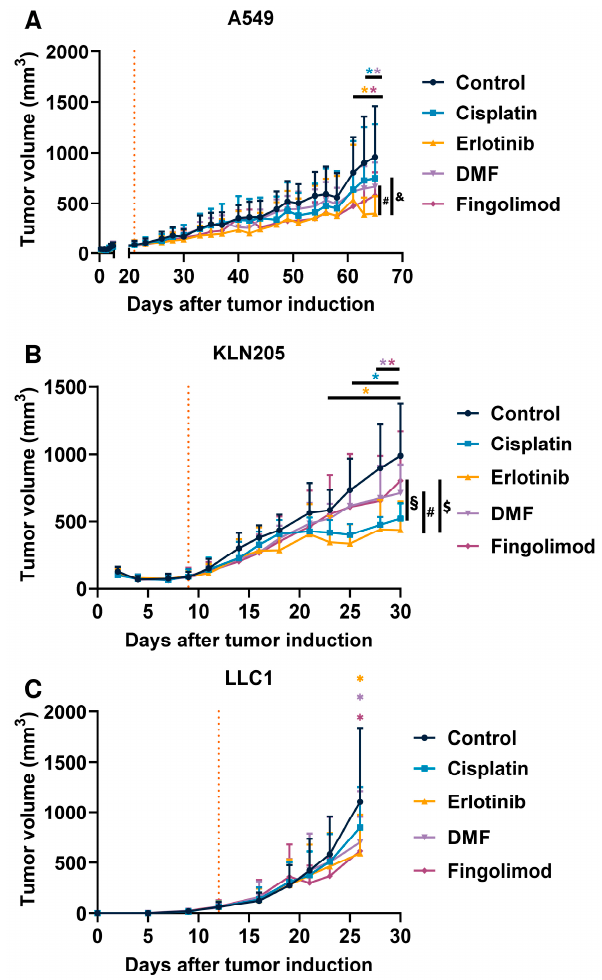
Figure 2. Effects of treatments in NSCLC mouse models. ( A – C ) Impact of Cisplatin at 1 mg/kg administrated 5 times a week (i.p.), Erlotinib at 50 mg/kg administrated 5 times a week (p.o.), DMF at 30 mg/kg administrated 5 times a week (p.o.), and Fingolimod at 5 mg/kg administrated 5 times a week (p.o.) on tumor volume in A549 xenograft ( A ), KLN205 syngeneic ( B ), and LLC1 syngeneic ( C ) mouse models. Discontinuous orange line highlights treatment beginning. Statistical differences between the groups were determined using a mixed-effects model (REML, groups, and time as factor) followed by Tukey’s multiple comparisons test (* p ≤ 0.05 treatment vs. control, & p ≤ 0.05 Cisplatin vs. Erlotinib, § p ≤ 0.05 Cisplatin vs. Fingolimod, # p ≤ 0.05 DMF vs. Erlotinib, $ p ≤ 0.05 Fingolimod vs. Erlotinib). Data represent mean and SD. n = 9–10 mice per group at the start of